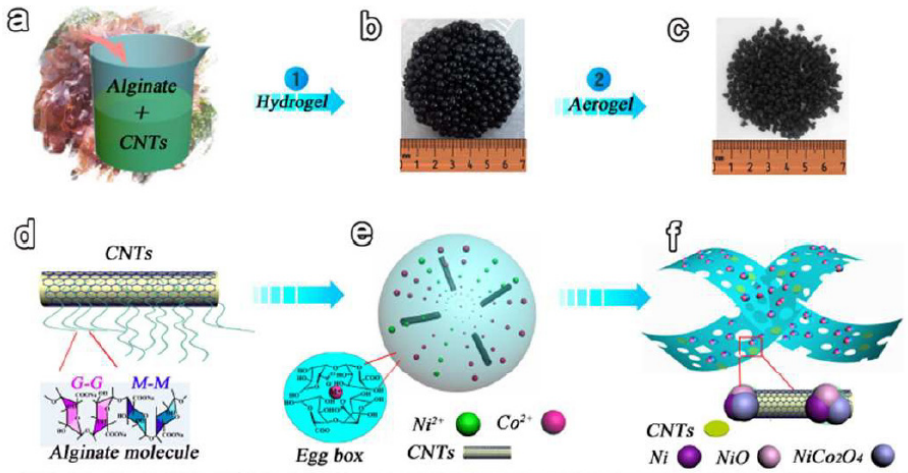
Figure 3. Schematic synthesis of Ni/NiO/NiCo2O4/N-CNT-As electrocatalysts; ( a , d ) shematic representation of SA with CNs, ( b , e ) hydrogels formed upon addition of aqueous solution containing Co 2+ and Ni 2+ ions; ( c , f ) freeze-dryied hydrogels formed aerogels. Reprinted with permission from [78]. Copyright 2015 The Royal Society of